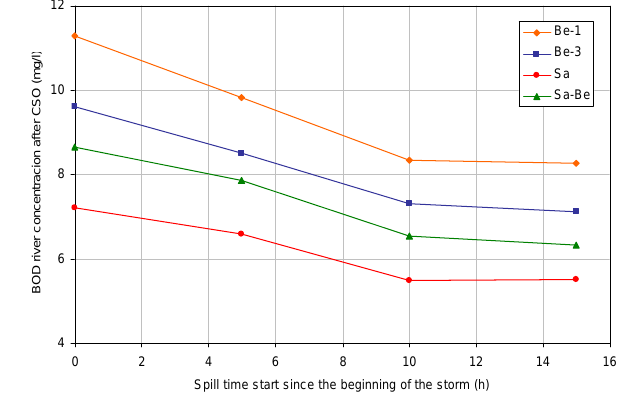
Fig. 9. BOD concentration in the river after CSO for different non- exceedance storm probabilities.